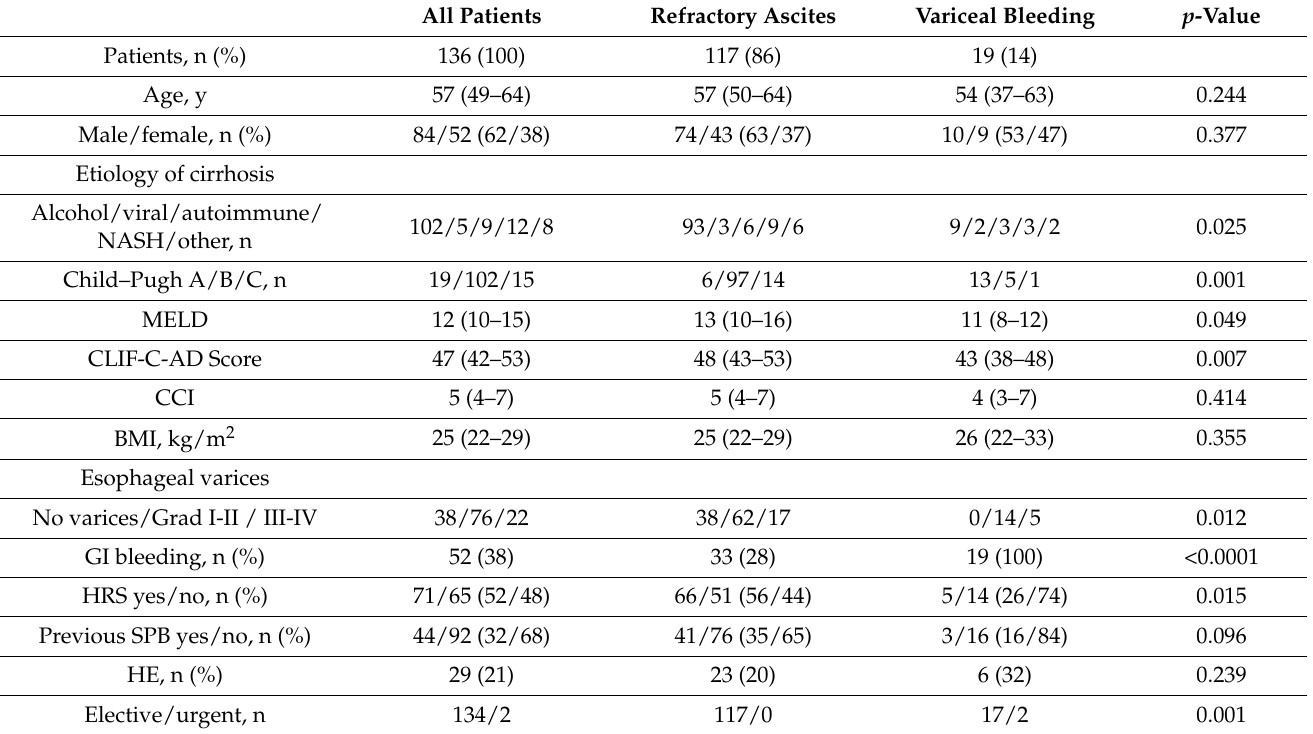
Table 1. Demographic and clinical characteristics by indication for TIPS at